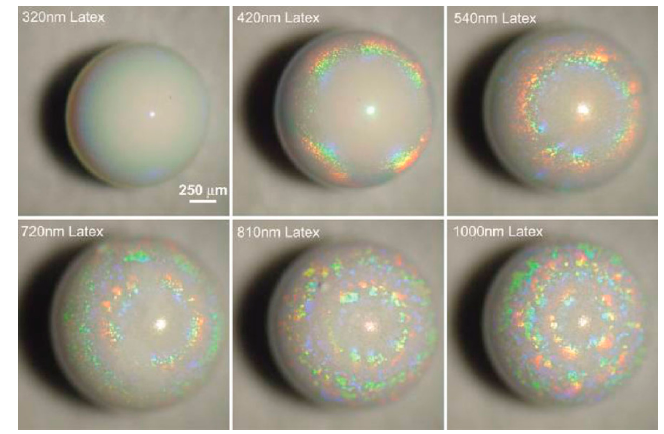
Figure 14. Optical microscopy images of patchy supraparticles assembled by EISA using differently-sized polystyrene (PS) latex microparticles in suspension droplets, thereby generating these highly light-diffracting “opal balls”. Reprinted with permission from [97] (p. 4266). Copyright 2008 Wiley.